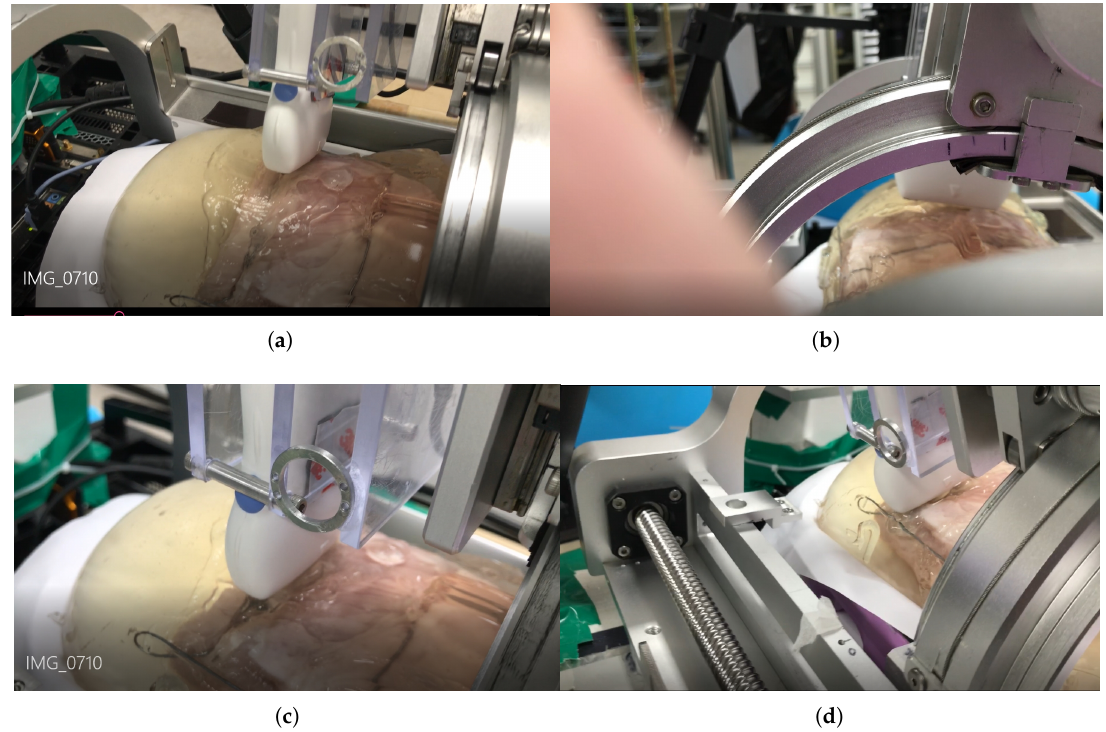
Figure 16. Phantom ultrasound scanning sequences. ( a ) Initial scanning position. ( b ) 1/3 scanning position. ( c ) 2/3 scanning position. ( d ) Final scanning